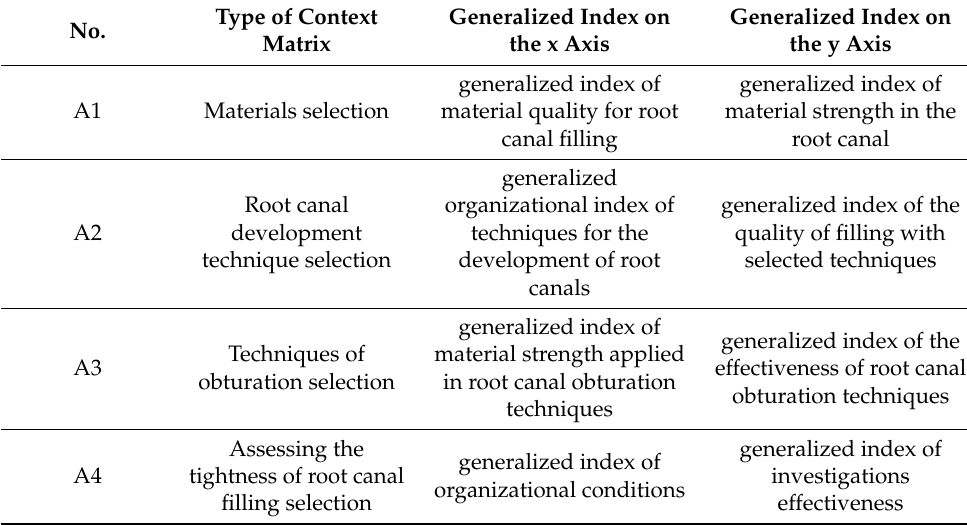
Table 1. Types of contextual matrices related to